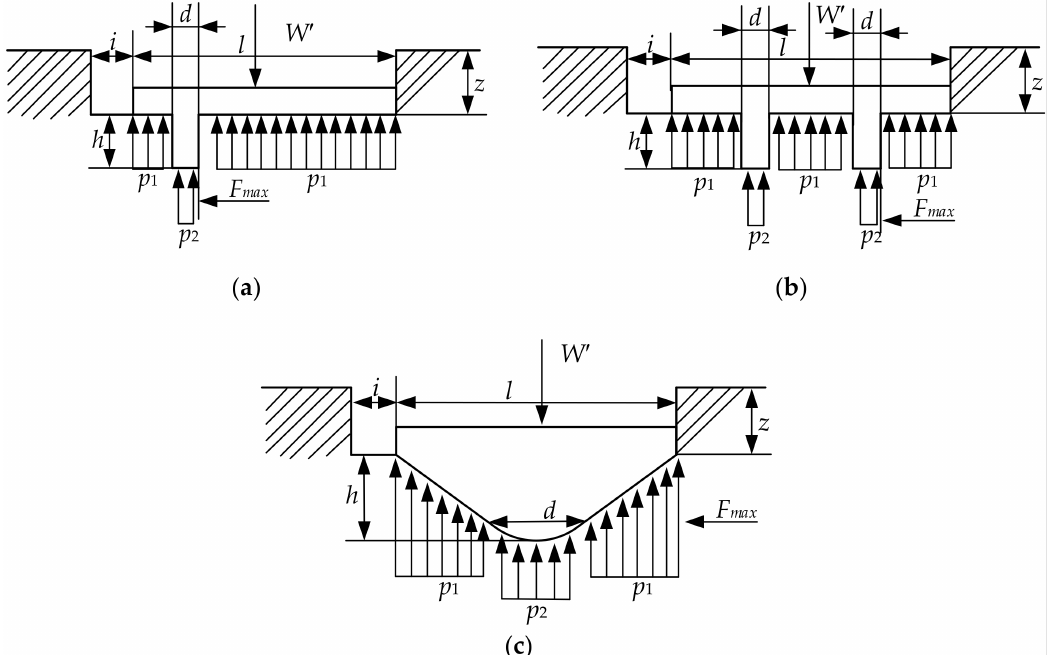
Figure 4. Schematic diagram of the interaction force between the track shoe and the soil. ( a ) Schematic diagram of the interaction force between an L-shaped track shoe and the soil. ( b ) Schematic diagram of the interaction force between a π -shaped track shoe and the soil. ( c ) Schematic diagram of the interaction force between a V-shaped track shoe and the